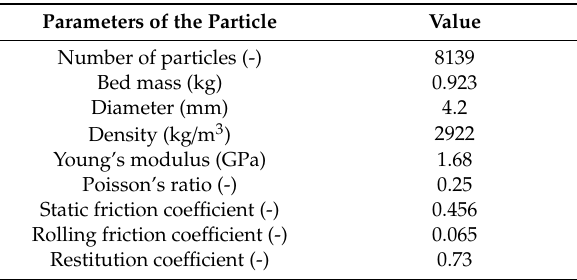
Table 3. DEM simulation parameters for the